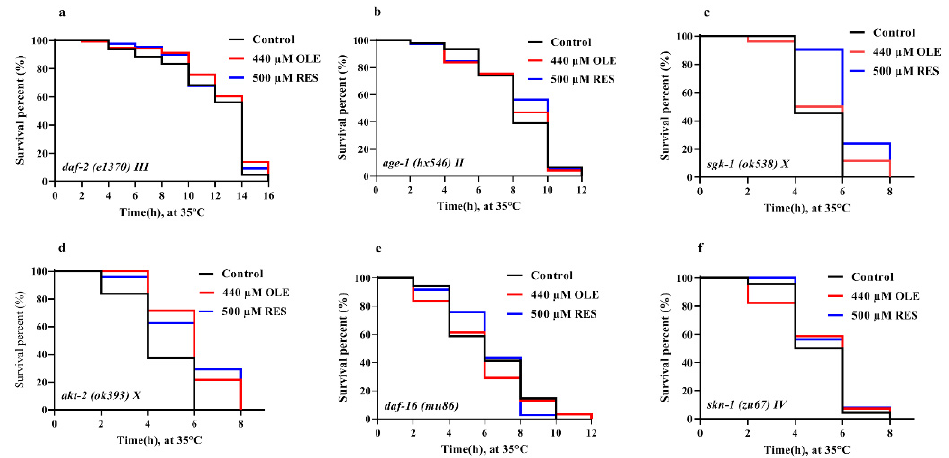
Figure 9. Effect of OLE on healthspan of worms under heat stress ( a ) daf-2 mutant worms; ( b ) age-1 mutant worms; ( c ) sgk-1 mutant worms; ( d ) akt-2 mutant worms; ( e ) daf-16 mutant worms; ( f ) skn-1 mutant worms.